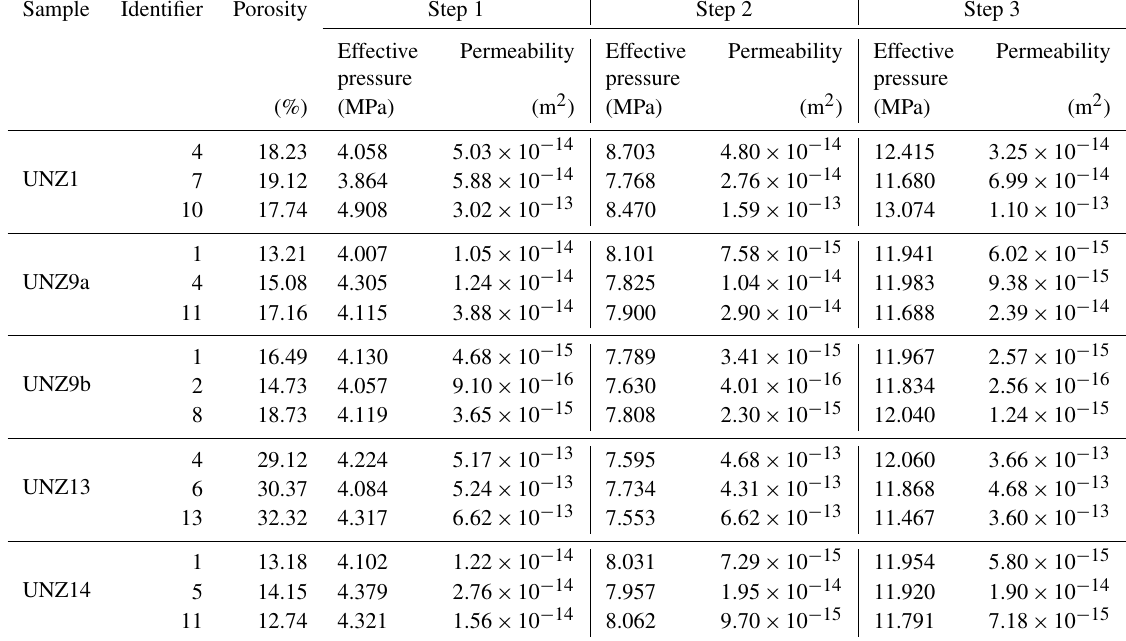
Table 3. Permeability under confined